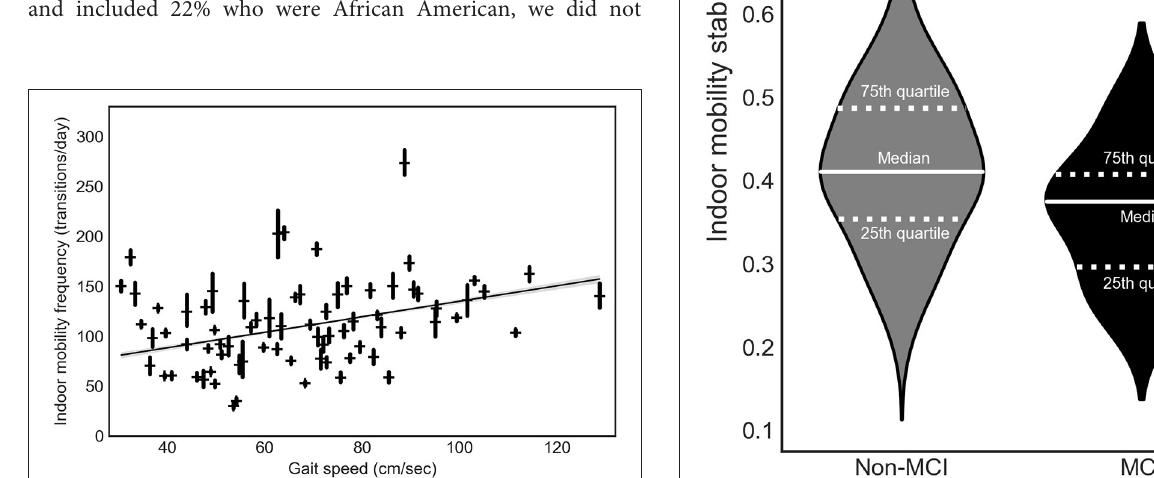
TABLE 2 | Generalized estimating equations models with outcomes being indoor mobility frequency and indoor mobility stability ( n Variable Outcome: Indoor mobility frequency Outcome: Indoor mobility stability Model without covariates Model with